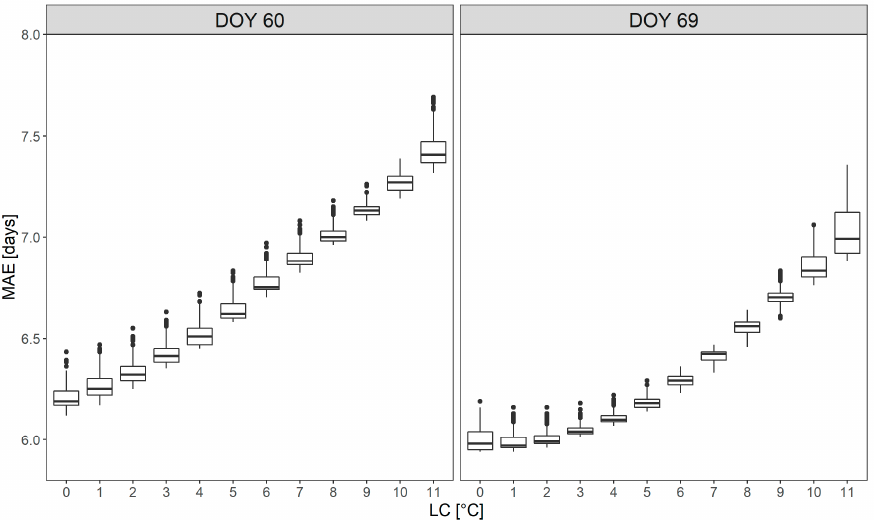
Figure 5. Boxplots of MAE values obtained with 5814 different combinations of NHH parameters, considering the starting date at DOY 60 and 69 in relation to the different values adopted for LC.